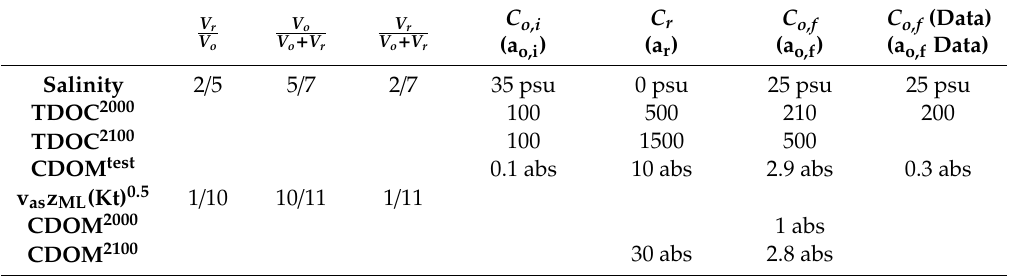
Table 5. Input and output from the box river-to-coast mixing model developed in our discussion section, with comparisons to the data in the last column. Concentrations retain the standard chemistry units of micromolar with two exceptions—practical salinity units and for the chromophoric organics, we substitute the proportional absorption coe ffi cient in per meter. Subscripts are fully defined in the text. Superscripts have the following significance: 2000 and 2100 are CE date-years denoting the recent contemporary era and a hypothetical globally warmed, amplified Arctic. Blank cells carry information downward from directly above. V r V o V r V o V o + V r V o + V